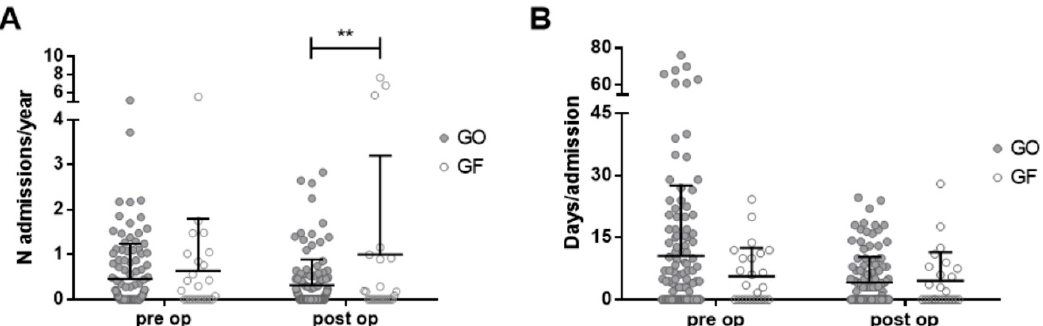
Figure 1. Long-term reflux-related hospitalization pre-operatively and post-operatively comparing gastrostomy only placement (GO) and gastrostomy plus fundoplication (GF). Bars for median and upper quartile. ( A ): Number of hospital admissions/years ( p = 0.004, 2-way ANOVA). ( B ): Length of hospital stay/admission ( p = 0.02, 2-way ANOVA). ** indicate that the difference between the two groups reached a statistical significance.